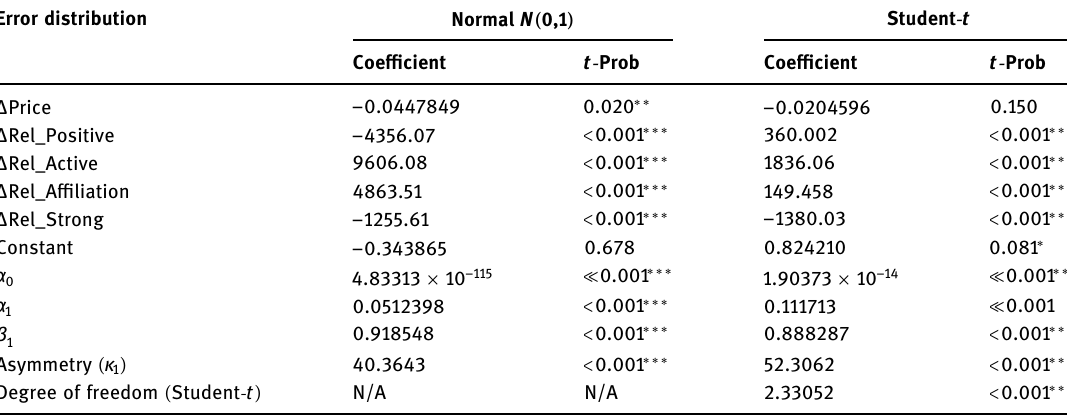
Table 6: AGARCH Model for FTSE